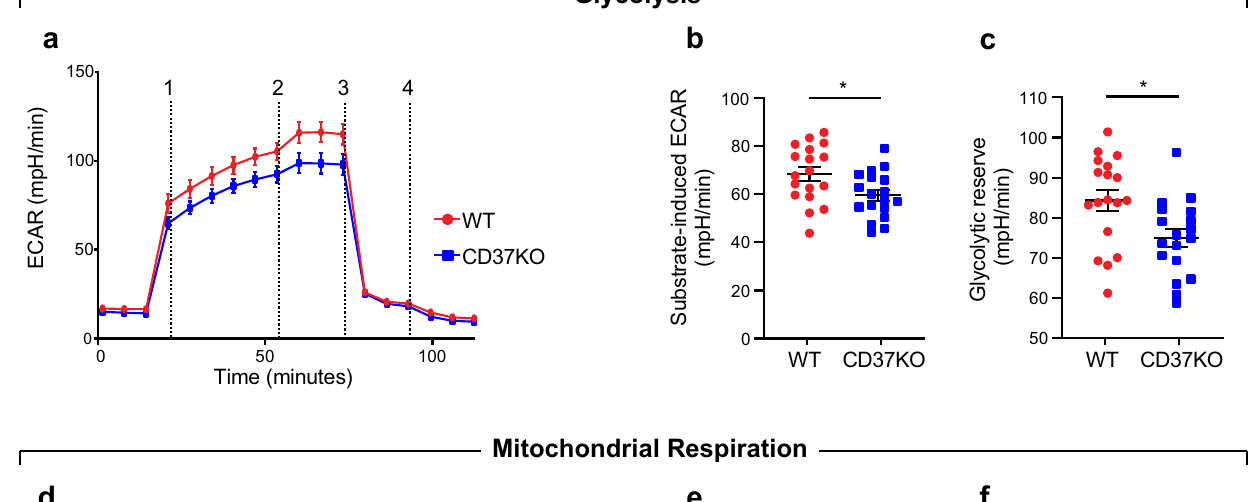
Oligomycin A (2) ( p= 0.0107). The spare respiratory capacity ( f ) was calculated as the difference in OCR between baseline and FCCP (7) ( p< 0.0001). Relative ATP production (counts per second, CPS) was assessed in response to Glucose ( n= 3, p= 0.0270)( g ), Palmitate ( n= 6, WT vs KO; p= 0.0145, KO − vs KO+; p= 0.0051) ( h ) andOleicacid( n= 6, p= 0.0110)( i )after2h( g ).Two-wayunpaired t -test( b , c , g )or Two-wayANOVA with Tukey ’ s post hoc test ( e , f , h , i ) wereperformed to checkfor signi fi cant differences between indicated groups, ns: not signi fi cant, * p< 0.05, ** p< 0.01, **** p< 0.0001. Error bars represent mean±SD. Experiments were repe- atedthreetimes,yieldingsimilarresults.SourcedataareprovidedasaSourceData fi le. See also Supplementary Fig.